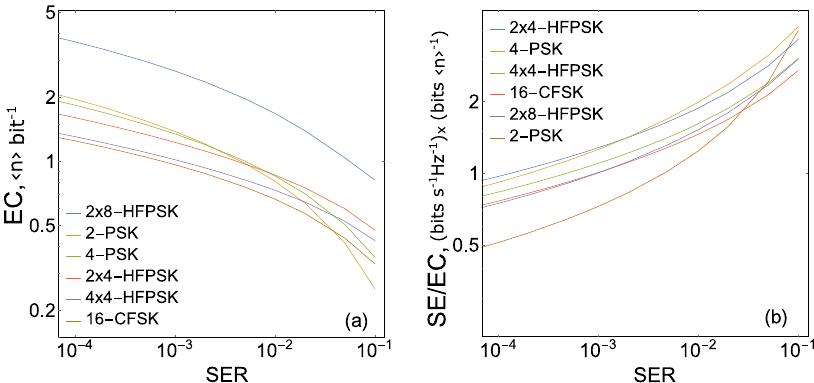
Fig. 2 Resource use of modulation schemes vs SER at the HB and their comparison to legacy modulation schemes. a Energy consumption, lower values are better. b Combined resource ef fi ciency calculated as SE/EC, higher values are better. Detunings Δ ω T of CFSK and HPSFK are optimized for the best SE/EC at the